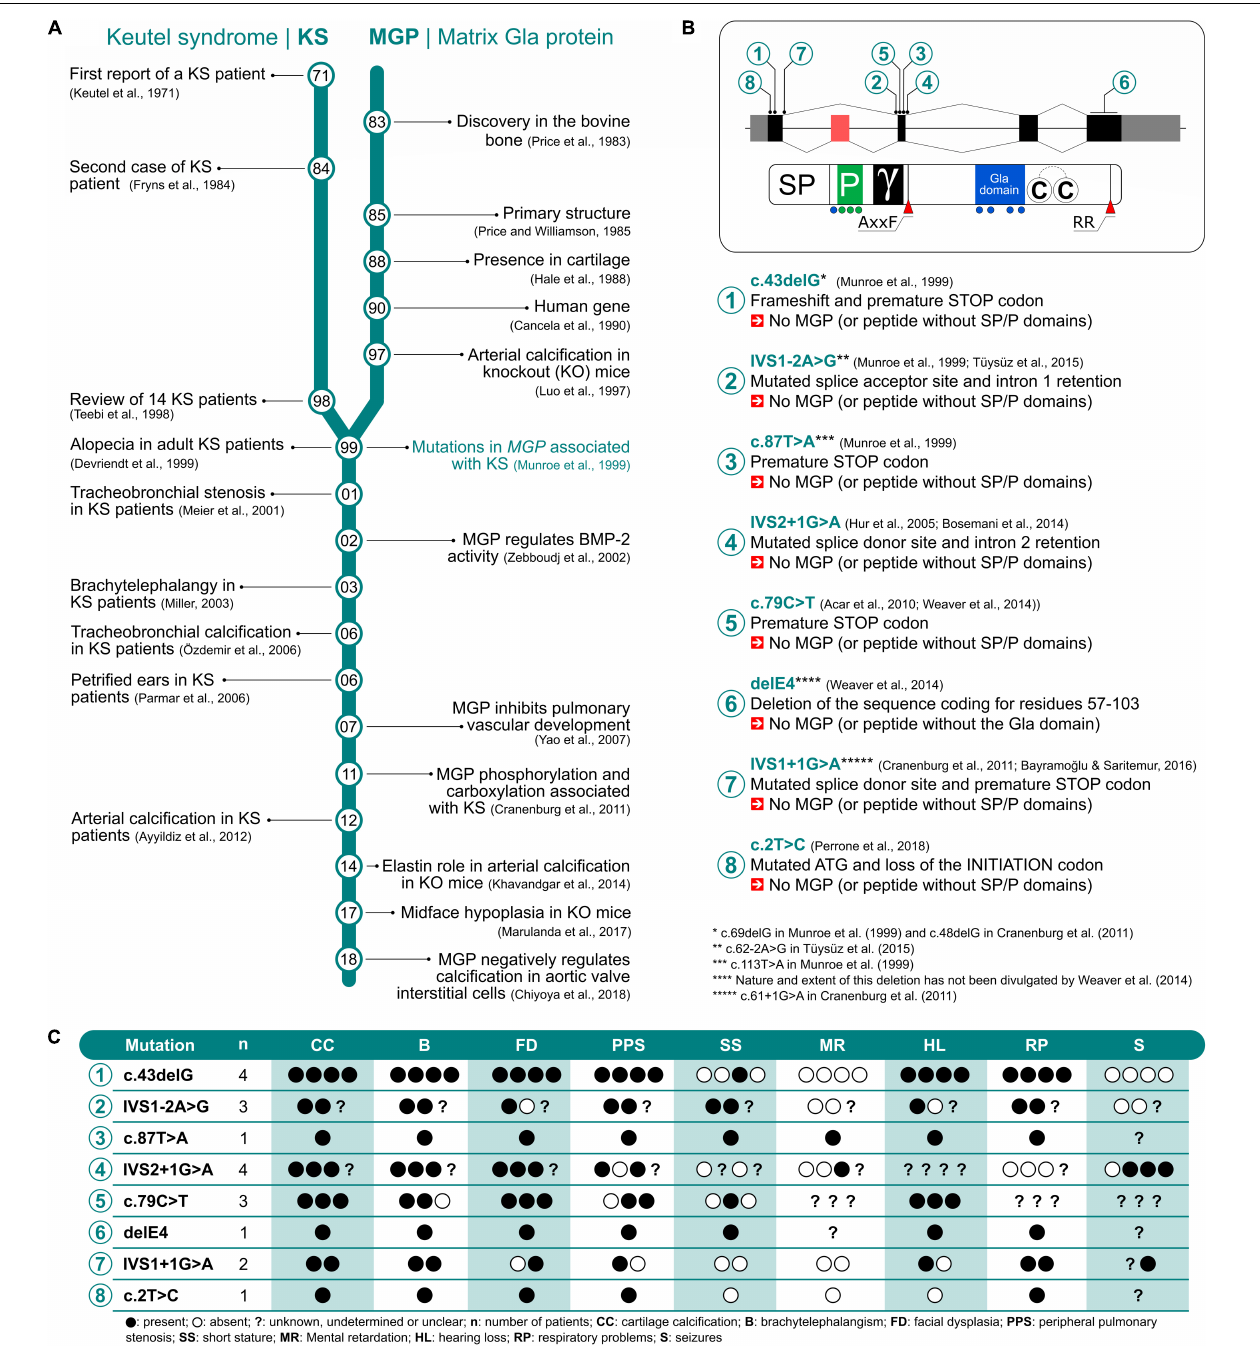
FIGURE 1 | Literature timeline for Keutel syndrome (KS) and matrix Gla protein (MGP) (A) . MGP gene and protein structure mapping the eight mutations associated with KS (B) . Most common traits observed in KS patients genotyped for MGP (C)